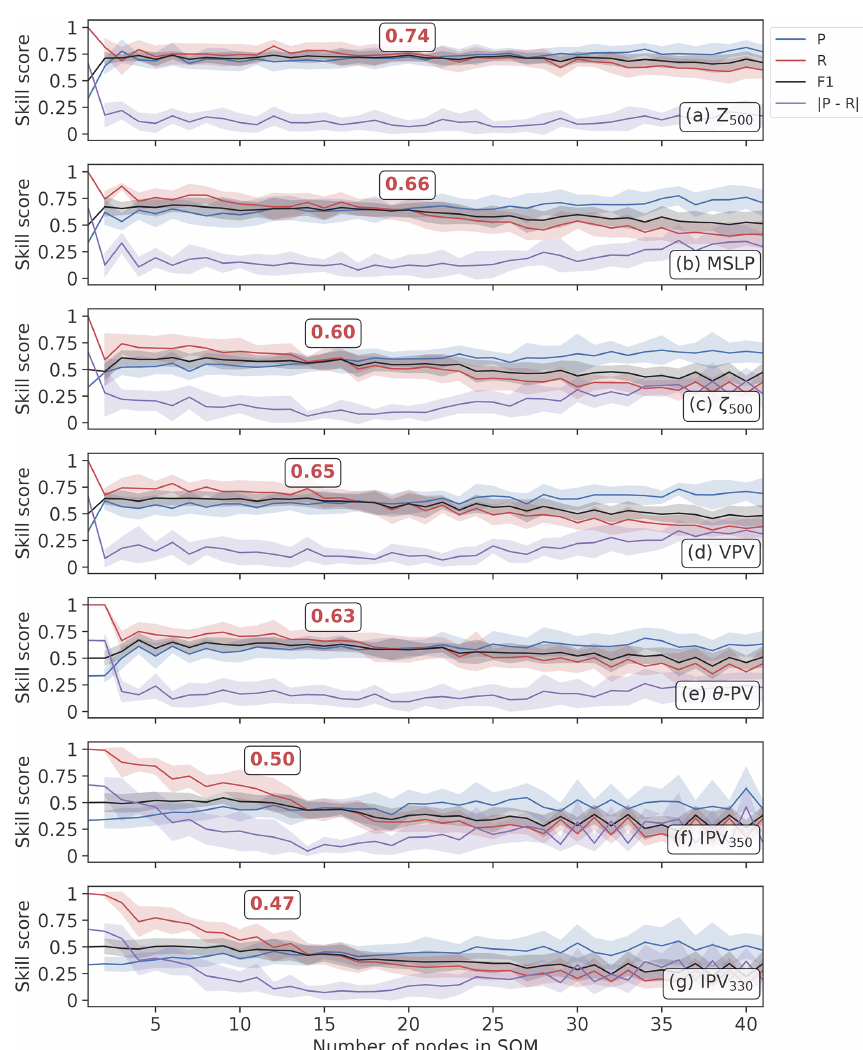
Figure 7. A comparison of the performance of the SOM blocking index for seven variables in the ERA5 1979–2019 historical period with a varying number of nodes in the SOM. Precision ( P ), recall (R) and F1 scores are calculated, and the absolute difference between precision and recall is also shown. Error bands show the standard deviation ( ± 1 σ ) for 10-fold cross-validation. The red number inset into each panel shows the optimal F1 score, and the position of the box indicates the corresponding optimal node number. The optimal value is defined by the node number where the F1 score is close to its maximum value and the difference between precision and recall is close to the minimum